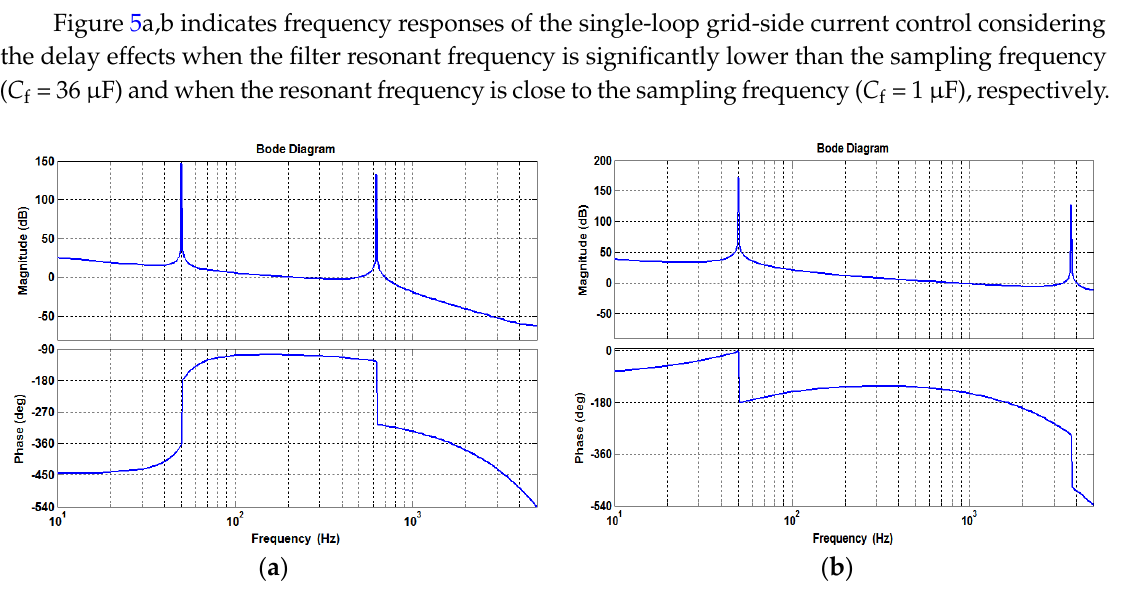
Figure 5. Bode plots of the open-loop gain in the grid-side current control scheme without any damping method: ( a ) C f = 36 μ F; and ( b ) C f = 1 μ F.